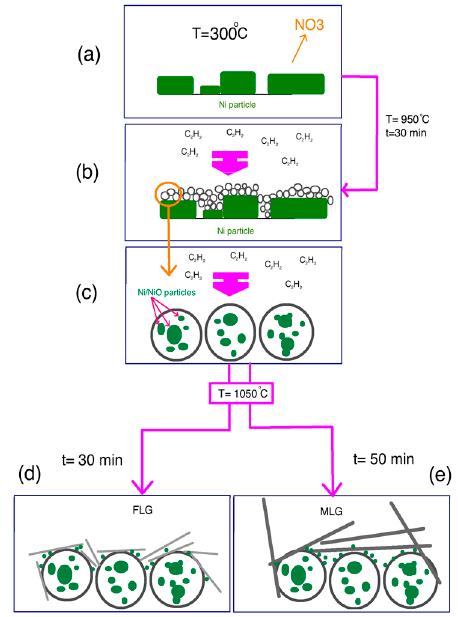
Figure 6. Schematic illustration of process: ( a ) NO 3 elimination and formation of Ni/NiO, ( b ) synthesis of carbon nanosphere, ( c ) zoon in of carbon nanosphere encapsulated Ni/NiO particles, ( d ) few-layer graphene and ( e ) Multi-layer graphene productions on CNS.